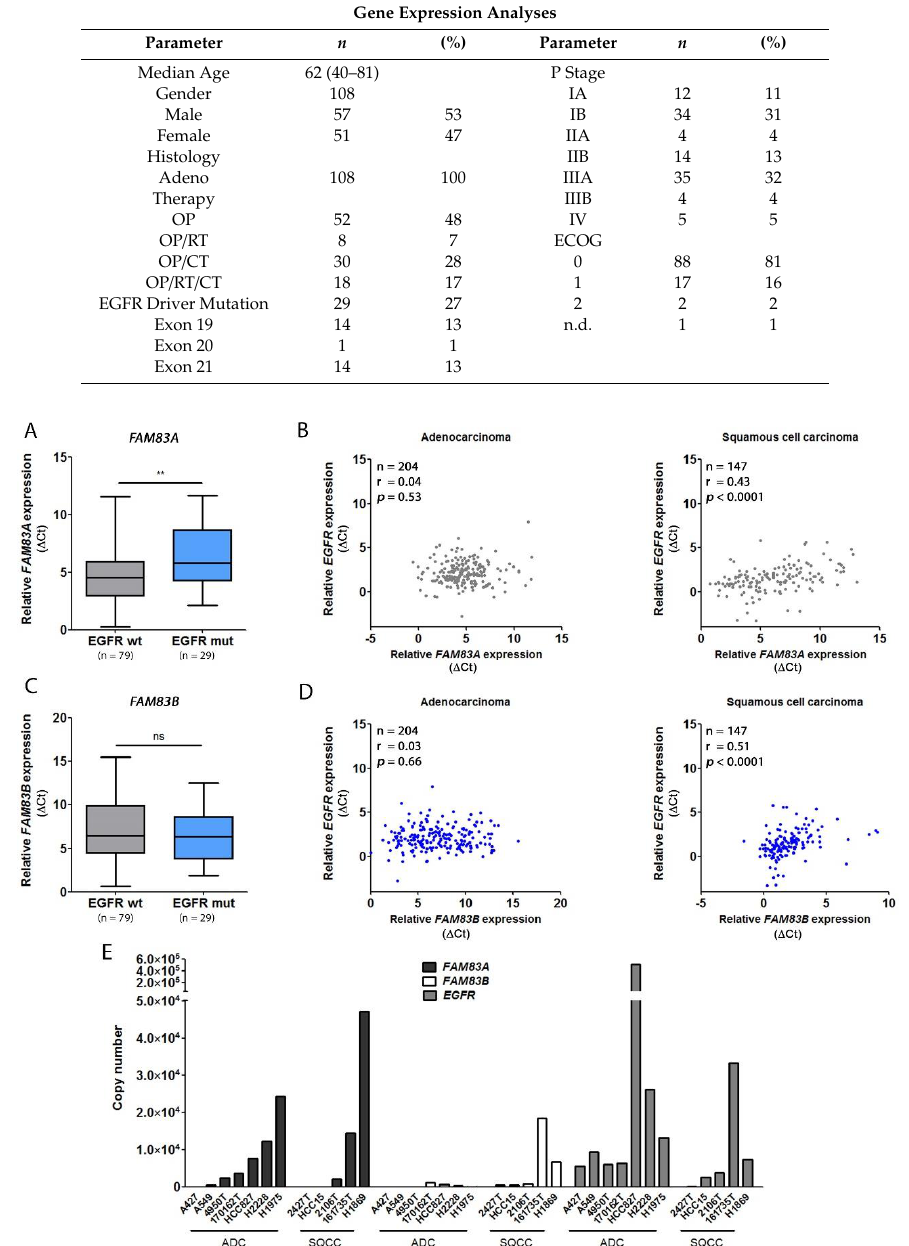
Table 4. Characteristics of the patients in the epidermal growth factor receptor (EGFR) cohort.